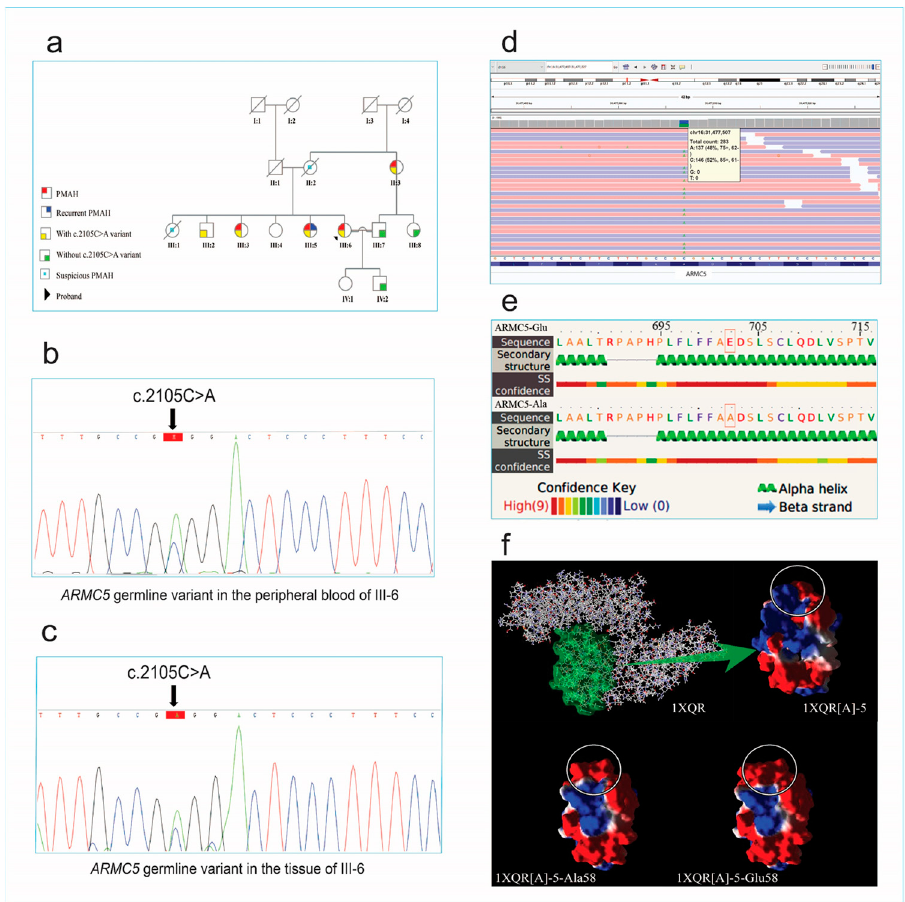
Figure 4. The pedigree of the family with familial PMAH, predicted secondary structure of ARMC5 and its tertiary structure (Adopted from 1XQR), BAM interfaces, and sanger confirmation results. ( a ) The pedigree of the patient (III-6). The arrows indicates the proband. ( b ) Sanger sequencing confirmation for the candidate causative variant of ARMC5 in the peripheral blood sample and ( c ) the tissue of the Patient (III-6). ( d ) The WES reads were visualized by using the Integrative Genomics Viewer (IGV). ( e ) Secondary structures of ARMC5 variants were obtained, using the Phyre online service. The substituted residues are highlighted in orange rectangles. ( f ) Tertiary structure of 1XQR is demonstrated in the top left. The 1XQR[A]-5 domain is highlighted in green, which is also electrostatically colored (on the right side of the arrow). The red, white, and blue represent negative, neutral, and positive charges, respectively, and the white circle represents the position of residues of interest either in 1XQR[A]-5 or in its variants. In 1XQR[A]-5 variants’, His58 is substituted with Ala58 and Glu58, which are named 1XQR[A]-5-Ala58 and 1XQR[A]-5-Glu58, respectively. A 44-year-old female (III-5, Figure 4a) admitted to the neurology ward with blurred vision and a headache underwent initial evaluation. The patient had a history of weight After a diagnosis of PMAH in her two sisters, a 39-year-old woman (proband gain, central obesity, proximal muscle weakness, hypertension (HTN), facial puffiness, and lower extremity edema which had started and progressed 2 years before admission.